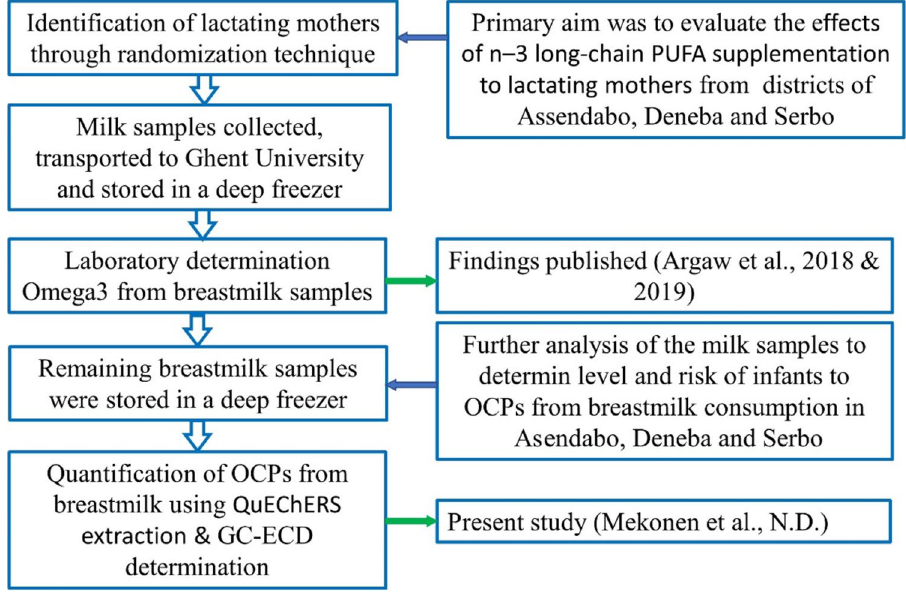
Figure 1. Flow diagram of the study showing general steps from sample source to OCPs residue data